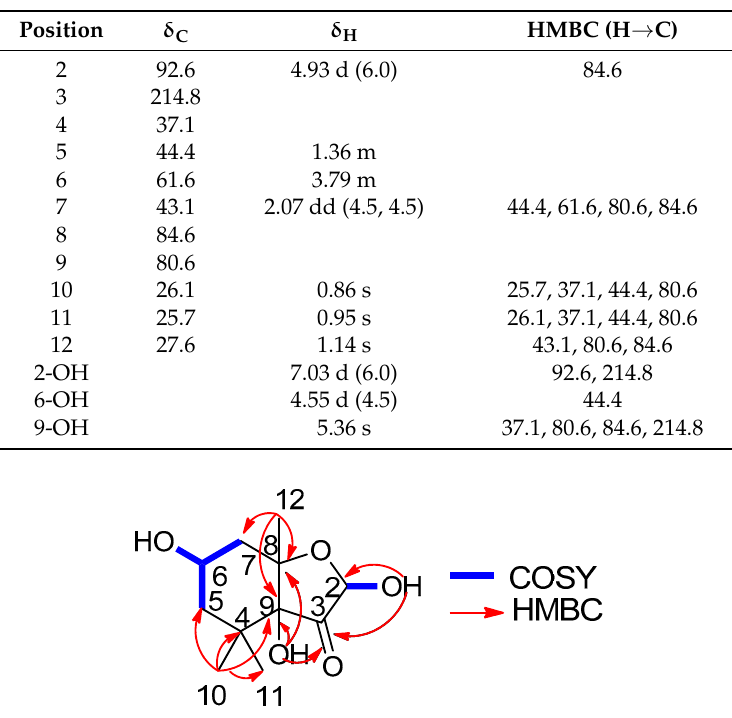
Figure 2. The key HMBC and COSY correlation of compound 1 .